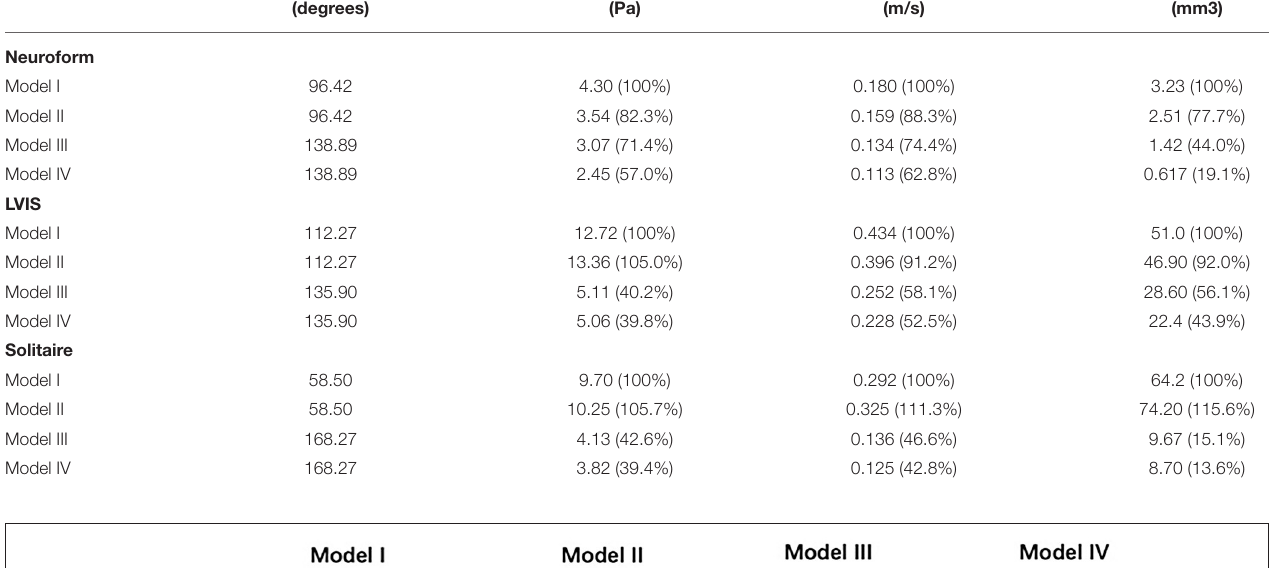
TABLE 2 | Angular measurements and hemodynamics of four models in three different stents.